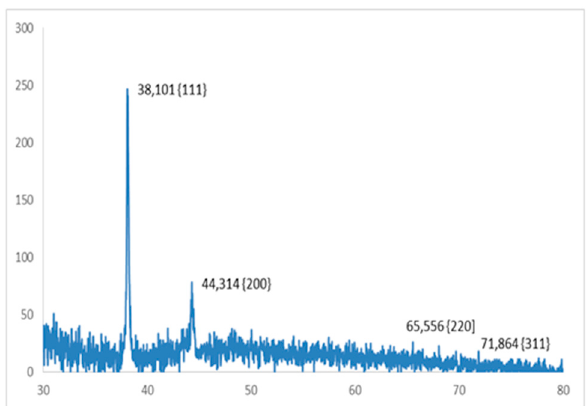
Figure 8. XRD pattern of triangular silver nanoplates stabilized by the mixture of gelatin 0.2 (%, w/v) and chitosan 0.06 (%, w/v) at pH 6.0.